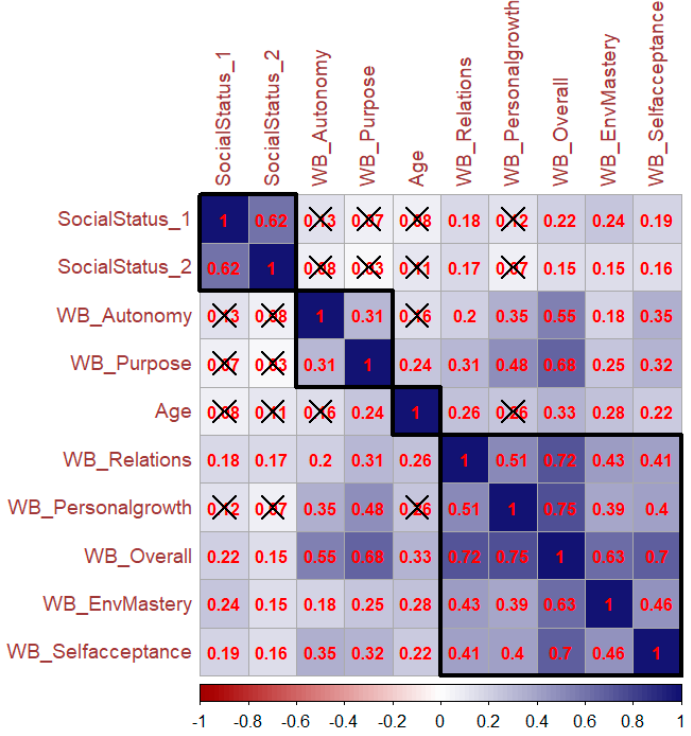
Figure 7. Correlations between WB components and chosen metric variables